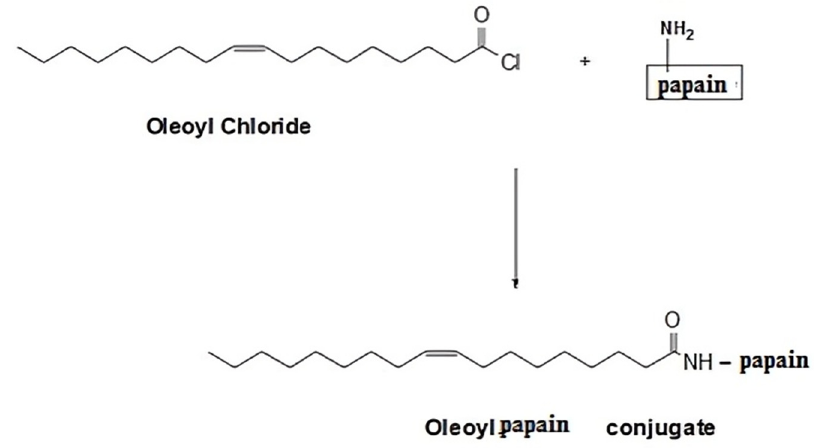
Figure 1. Schematic illustration of covalent linkage of papain to oleoyl chloride and hypothetical chemical formula of OC-PAP.